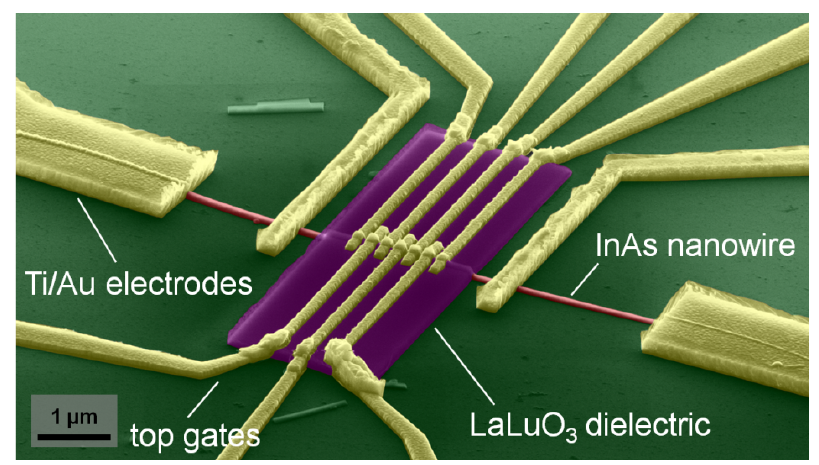
Figure 1: Gated Nanowire Mulitple Quantum Point Device (Heedt et al., 2016)